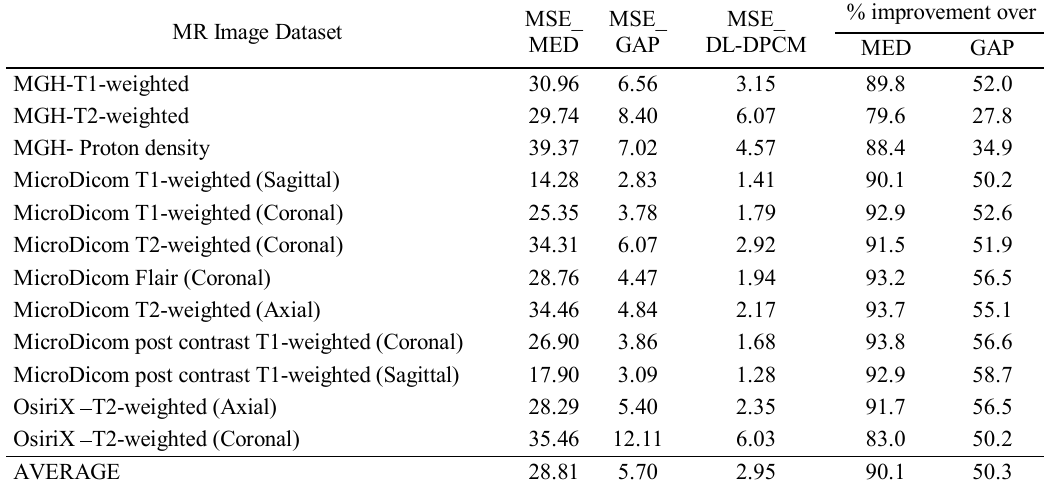
Note: MSE_MED: MSE between original image and image predicted using MED predictor, MSE_GAP: MSE between original image and image predicted using GAP predictor, MSE_DL-DPCM: MSE between original image and image predicted using DL-DPCM